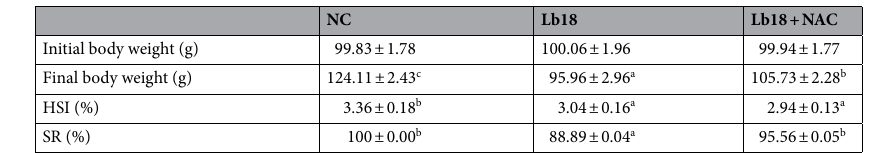
Table 2. Effects of infection with P. vulgaris and E. meningoseptica on growth performance of Chinese soft- shelled turtles. Values represent the mean ± S.E. (n = 3 replicate tanks), all turtles were sampled for each tank. Values within the same row having different superscripts are significantly different ( p < 0.05).